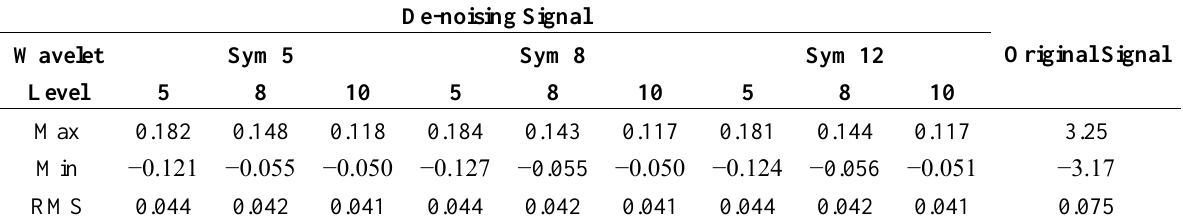
Table 1. Comparative result of application different wavelet order and decomposition level